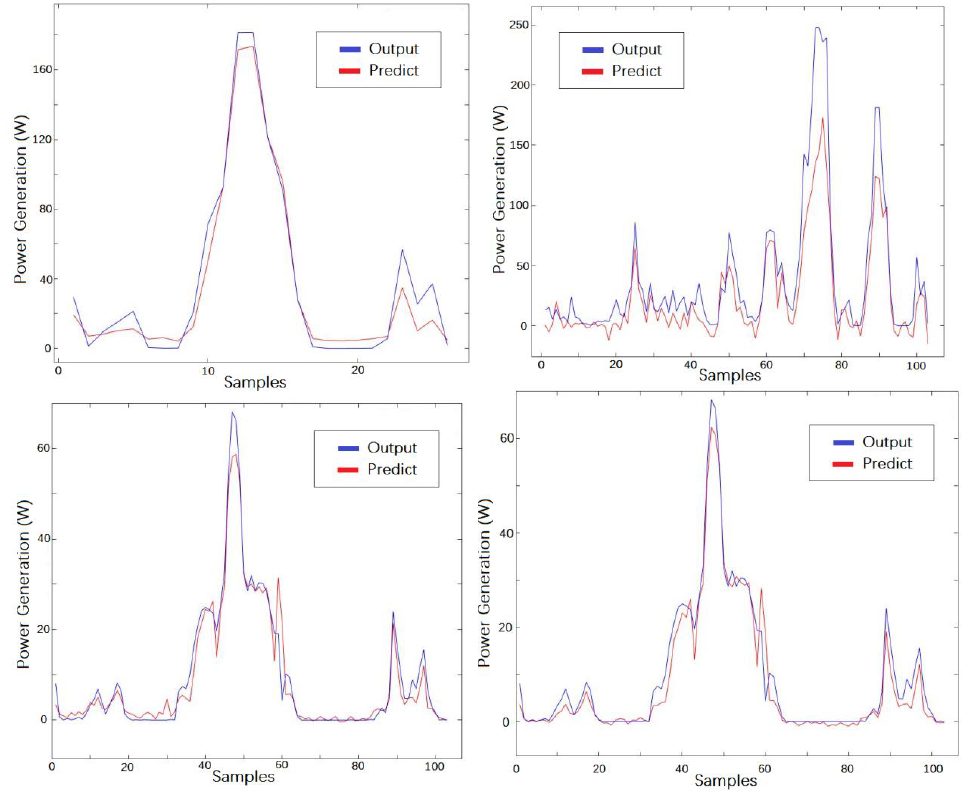
Figure 9. The comparison of the prediction results from different conversion methods based on 28 × 28 dimension image, with 1st to 4th conversion method being presented from top left to right bottom subplot.